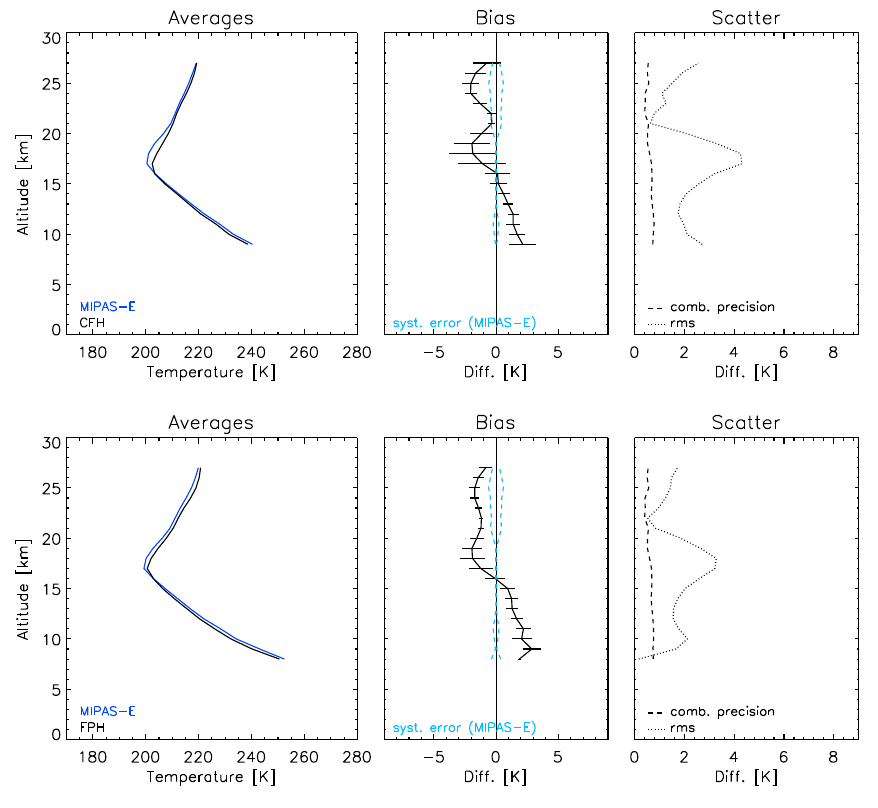
Fig. 4. Same as Fig. 2, but for RS92 radiosonde temperature profiles recorded during flights with the CFH (top row) and NOAA FPH (bottom row) frost point hygrometers. For a more detailed description see Fig. 2.